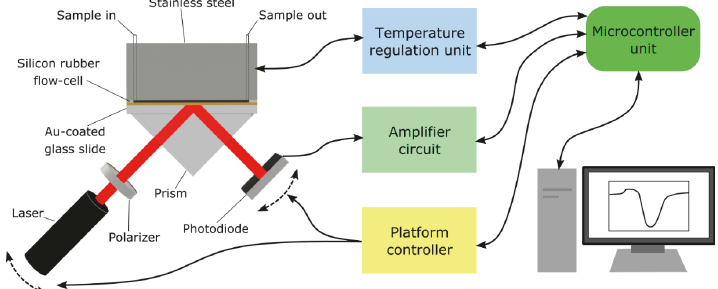
Figure 1: Schematic representation of the complete SPR system.